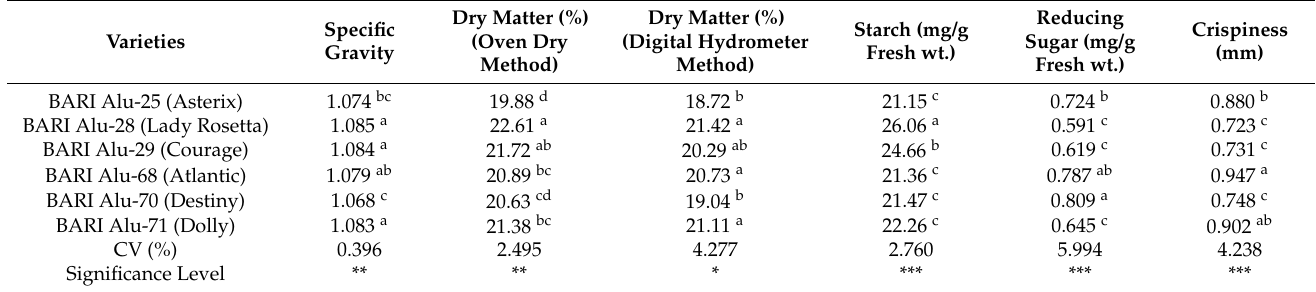
Table 3. Various processing quality parameters of potato